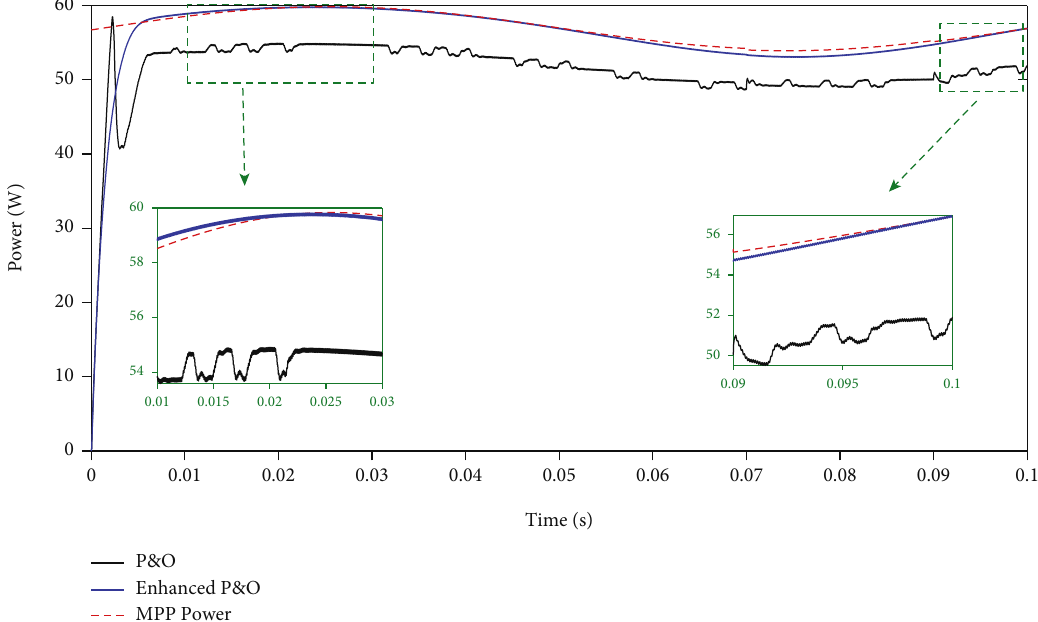
Figure 19: Tracking of MPP power with P&O and enhanced P&O MPPT method under Test 3.